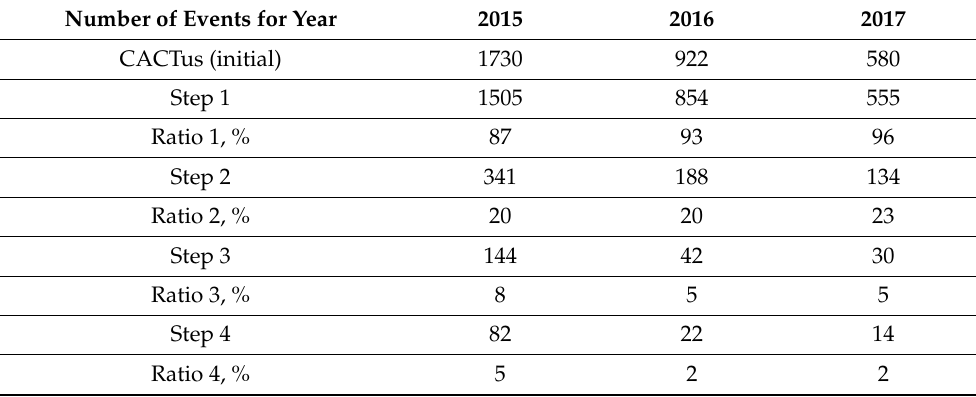
Table 1. The number of events passed each step in the selection algorithm in the periods of 2015, 2016 and